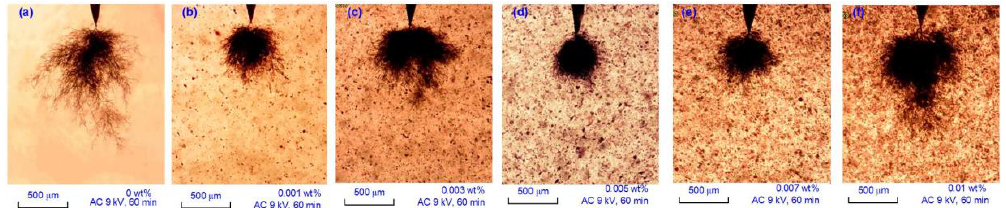
Figure 6. Tree structures at different graphene contents. ( a ) Bush-branch tree at 0 wt %; ( b – f ) bush trees at 0.001–0.010 wt